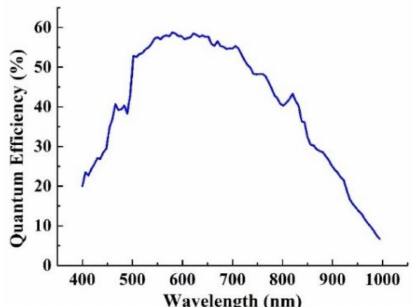
Figure 7. Quantum e ffi ciency curve of image